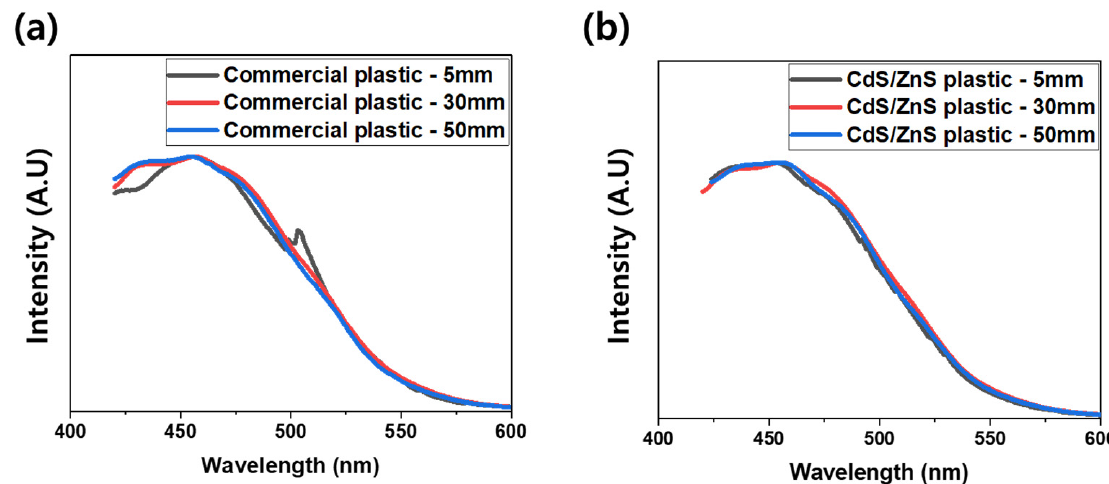
Figure 6. Photoluminescence analysis of ( a ) commercial plastic scintillator and ( b ) CdS/ZnS-based plastic scintillator.